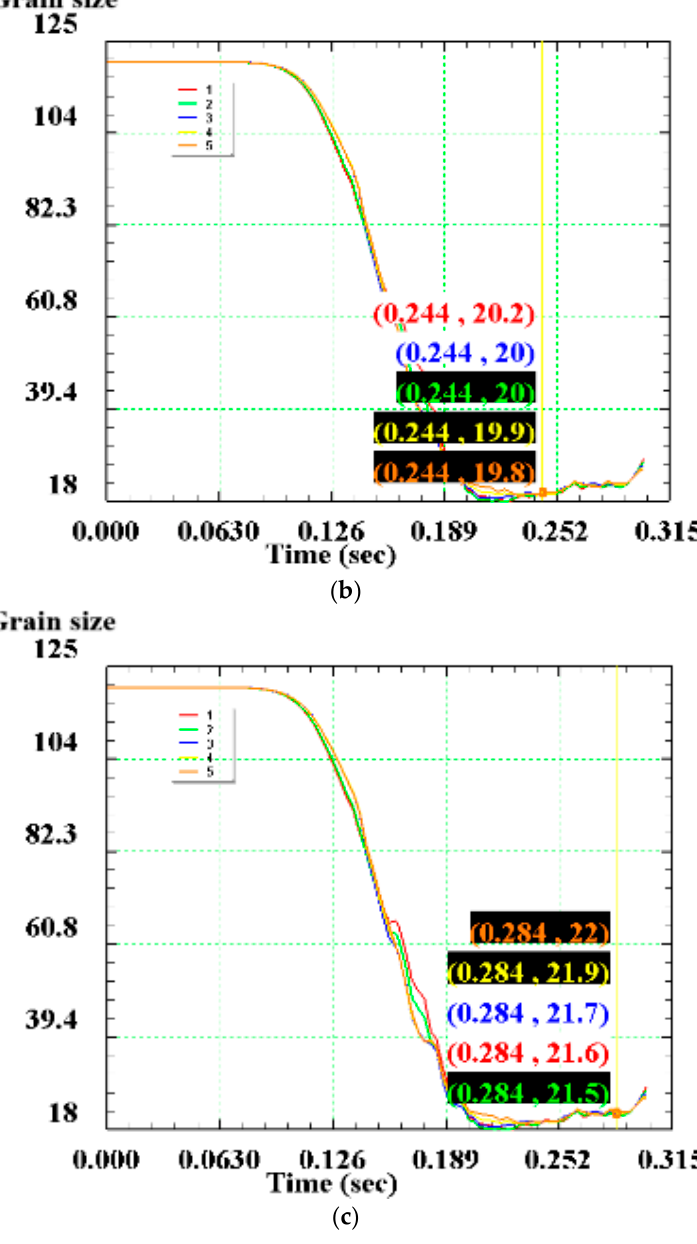
Figure 14. Dynamic recrystallized grain size at each tracking point: ( a ) L = 100%; ( b ) L = 125%; ( c ) L = 150%.